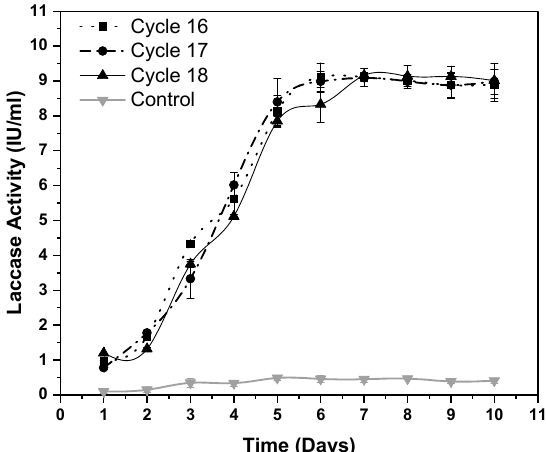
Figure 5. Maximal laccase activity in adapted strains of Geobacillus sp. strain WSUCF1 (eWSUCF1) during laboratory adaptive evolution with 0.5% ( w / v ) unprocessed corn stover (CS) and 0.025% ( w / v ) kraft lignin, at 60 ◦ C, pH 7.0, and agitation speed of 150 rpm, after 10 days of incubation. Here, IU = International Units. Note: All the experiments were performed in triplicates, with data averaged and presented as the mean ± standard deviation